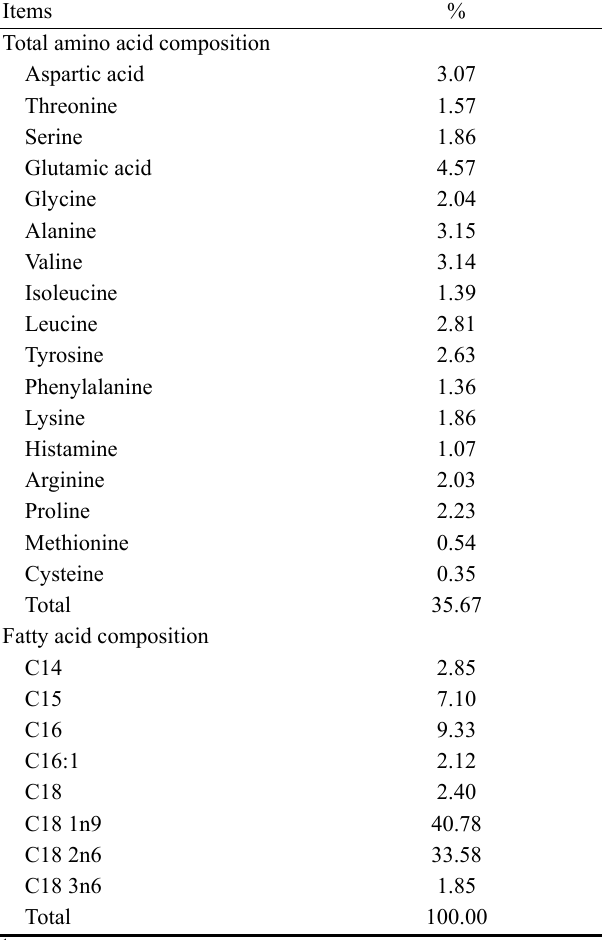
Table 1. Composition of total amino acid 1 and fatty acid 2 in dried mealworm larvae (dry matter